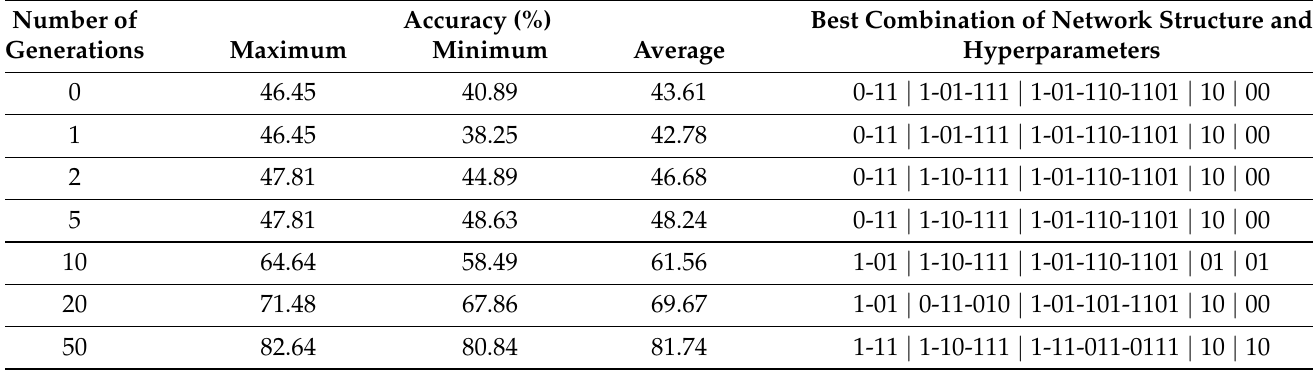
Figure 6 visualises the accuracy values for each generation in graph form. Convergence of three accuracy values is observed, showing that all individuals in the algorithm found the ideal neural architecture as the number of generations increases.